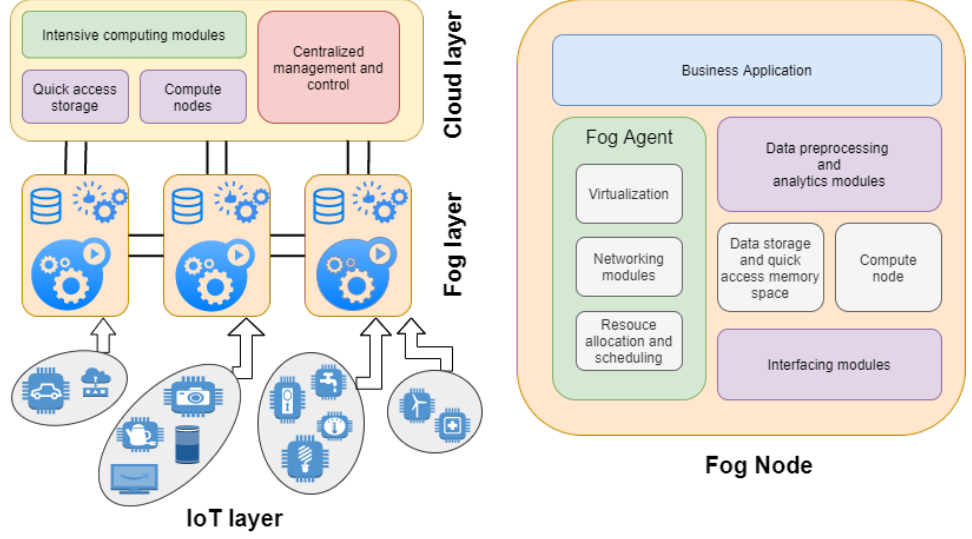
Figure 3. Architecture of fog